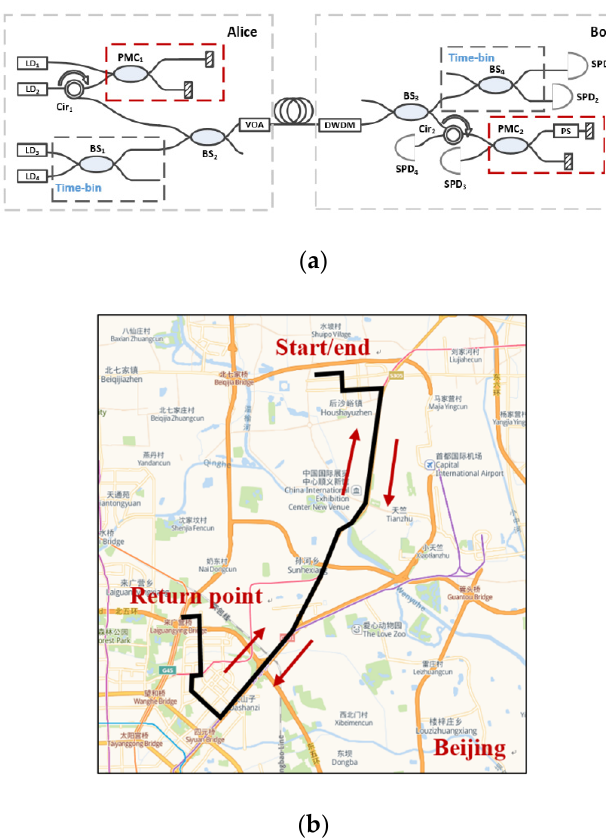
Figure 4. ( a ) schematic diagram of the Q–M interferometer based time-bin phase encoding intrinsic-stabilization QKD system. The Q–M interferometers are shown in red dashed boxes. LD 1 –LD 4 : lasers, Cir 1 and Cir 2 : optical circulators, PMC 1 and PMC 2 : polarization maintaining couplers, BS 1 –BS 4 : beam splitters, PS: phase shifter, DWDM: dense wavelength division multiplexer, VOA: variable optical attenuator, SPD 1 –SPD 4 : avalanche diode single photon detectors; ( b ) the geographic distribution of the quantum channel with a 60.6 km standard telecommunication optical fiber.